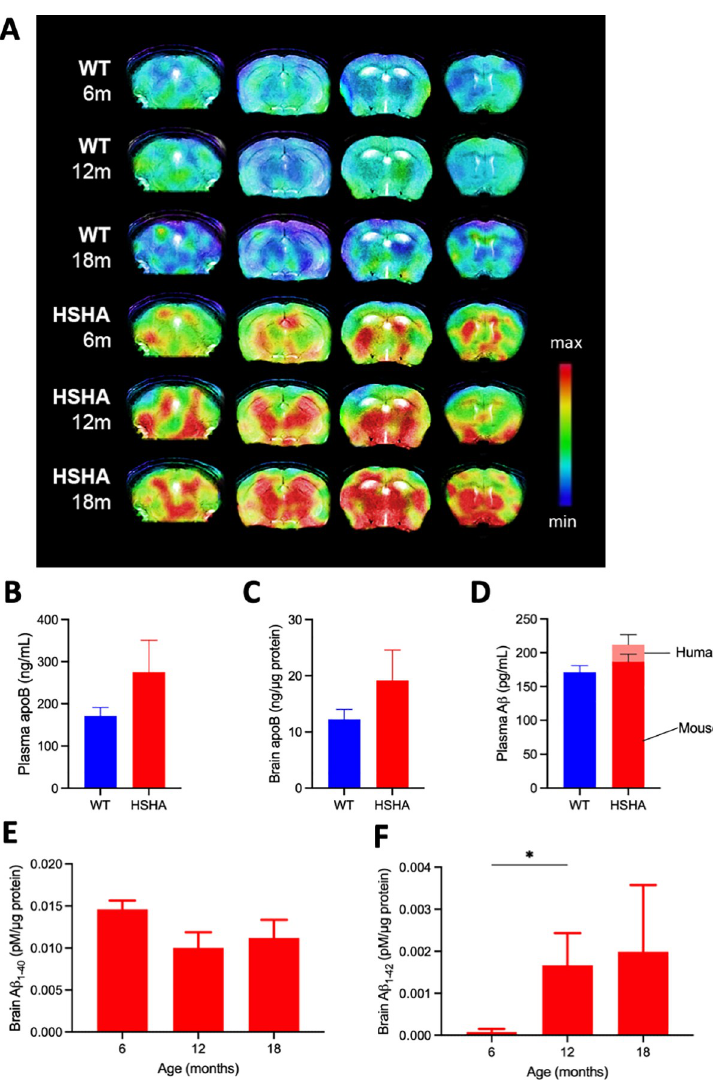
Fig 2. Plasma and brain concentrations of apo B and A β . (A) In vivo PET detection of amyloid binding was used to confirm cerebral amyloid deposition in HSHA mice and their age-matched WT controls. Representative PET and MRI fusion images (coregistered with MRI templates using conventional Fast Spin Echo Sequence T2-weighted sequence) show scan data at 20 to 40 minutes’ post-intravenous administration of [ 11 C] PiB. Each panel (from left to right) illustrates maximum binding potential for [ 11 C] PiB represented by coronal images at − 2, 0, 4, and 6 mm from the bregma; indicated by the vertical bar. Plasma (B) and brain (C) levels of apo B, a surrogate marker of TRLs in HSHA and WT control mice, were determined with ELISA. Data are expressed as mean ± SEM. Human and mouse isoforms of A β in plasma (D) and brain (E, F) were measured separately with ELISA kits using antibodies specific to each isoform. The data underlying Fig 2B–2F can be found in S1 Data. A β , amyloid beta; apo B, apolipoprotein B; HSHA, hepatocyte-specific human amyloid; MRI, magnetic resonance imaging; PET, positron emission tomography; PiB, Pittsburgh compound; TRL, triglyceride-rich lipoprotein; WT, wild-type. associated accumulation of neutral lipids (triglyceride/esterified cholesterol) throughout the HPF in HSHA mice compared to aged-matched WT controls (Fig 3Y). To explore if the accel- erated accumulation of LIBs/neutral lipid demonstrated by Herxheimer staining and FTIR might potentially reflect exaggerated extravasation of blood-derived TRLs, we determined parenchymal distribution of apo B, an exclusive marker of TRL and their remnants. Apo B is